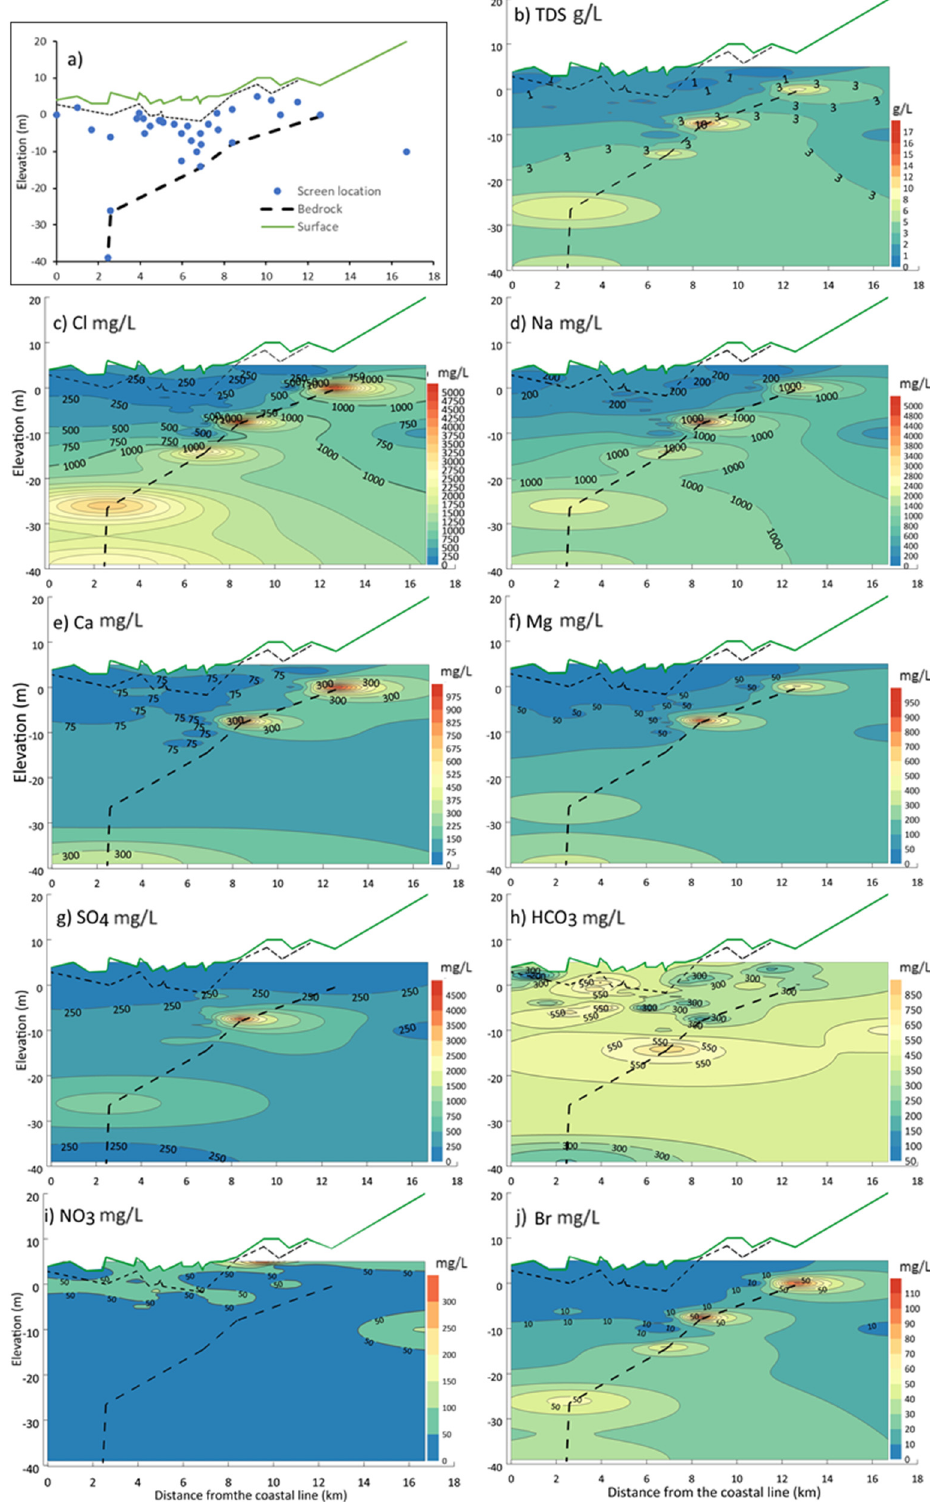
Figure 4. ( a ) Vertical well screen positions along the CD profile in Figure 1. The thick black dashed line indicates the bedrock surface, the green line is the surface elevation line and the thin black line is the elevation of the water table in the wells. ( b – j ) interpolation of TDS and ion concentration from water samples along profile CD.